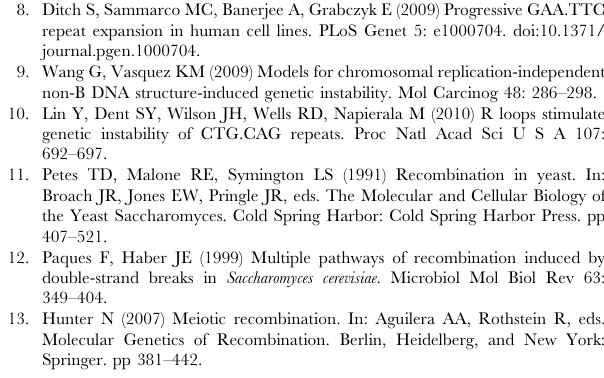
Table S3 Genotype of diploid strains. 1 For the diploid genotypes in the strains WXTMD40-WXTMD43, WXTMD44,